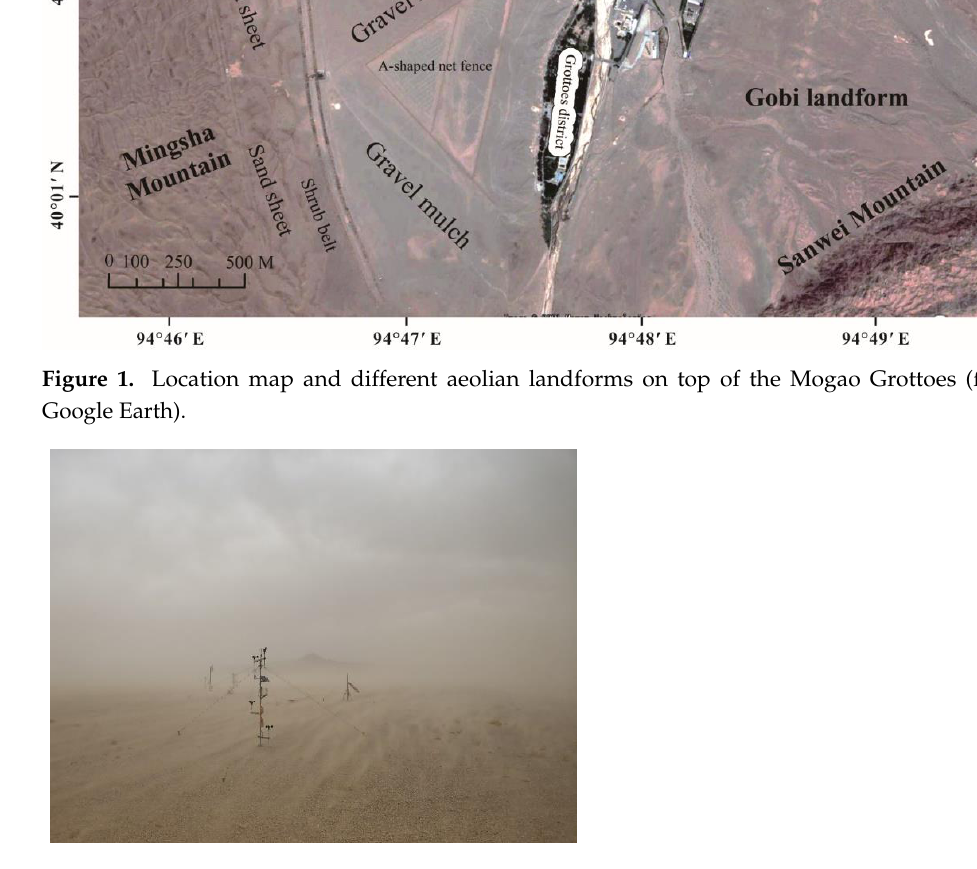
Figure 2. A dust storm occurred atop the Mogao Grottoes on 28 May 2020.